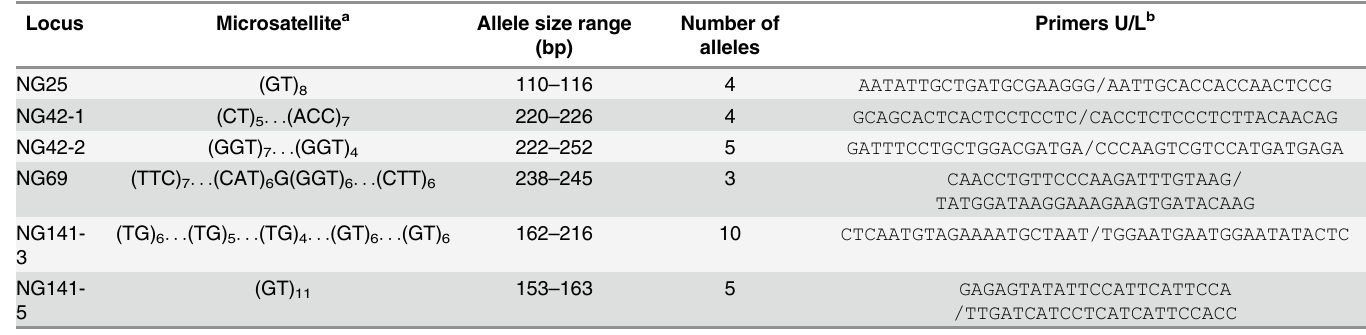
Table 2. Microsatellites loci and